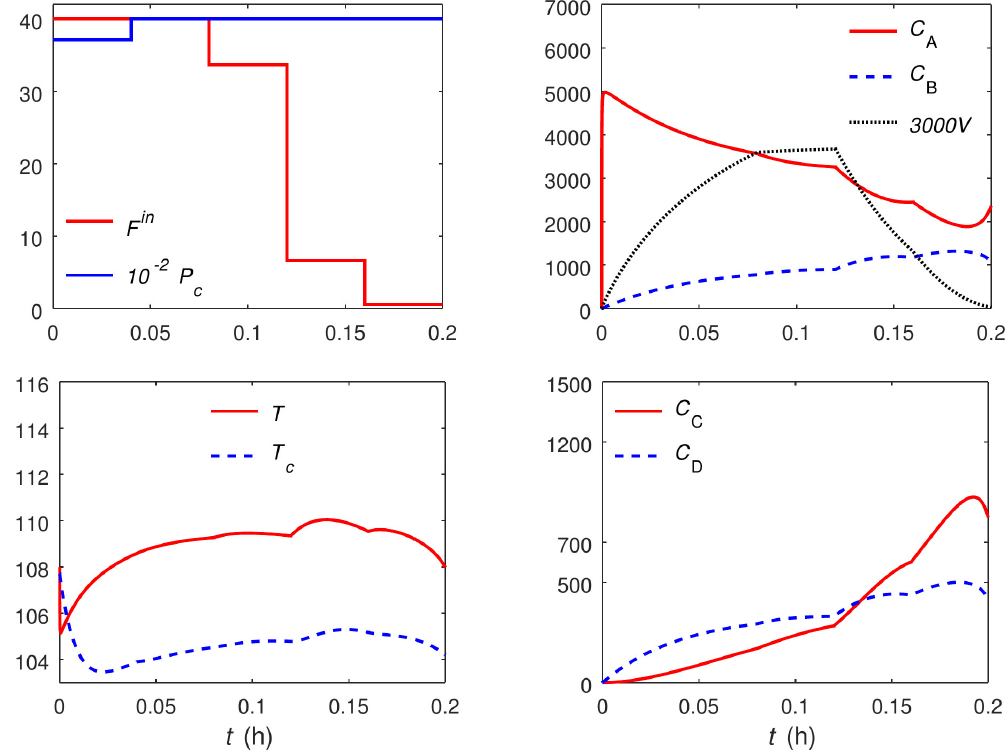
Figure 9. Optimal trajectories for Problem (40) with a short time horizon solved using a uniform discretization and N = 5